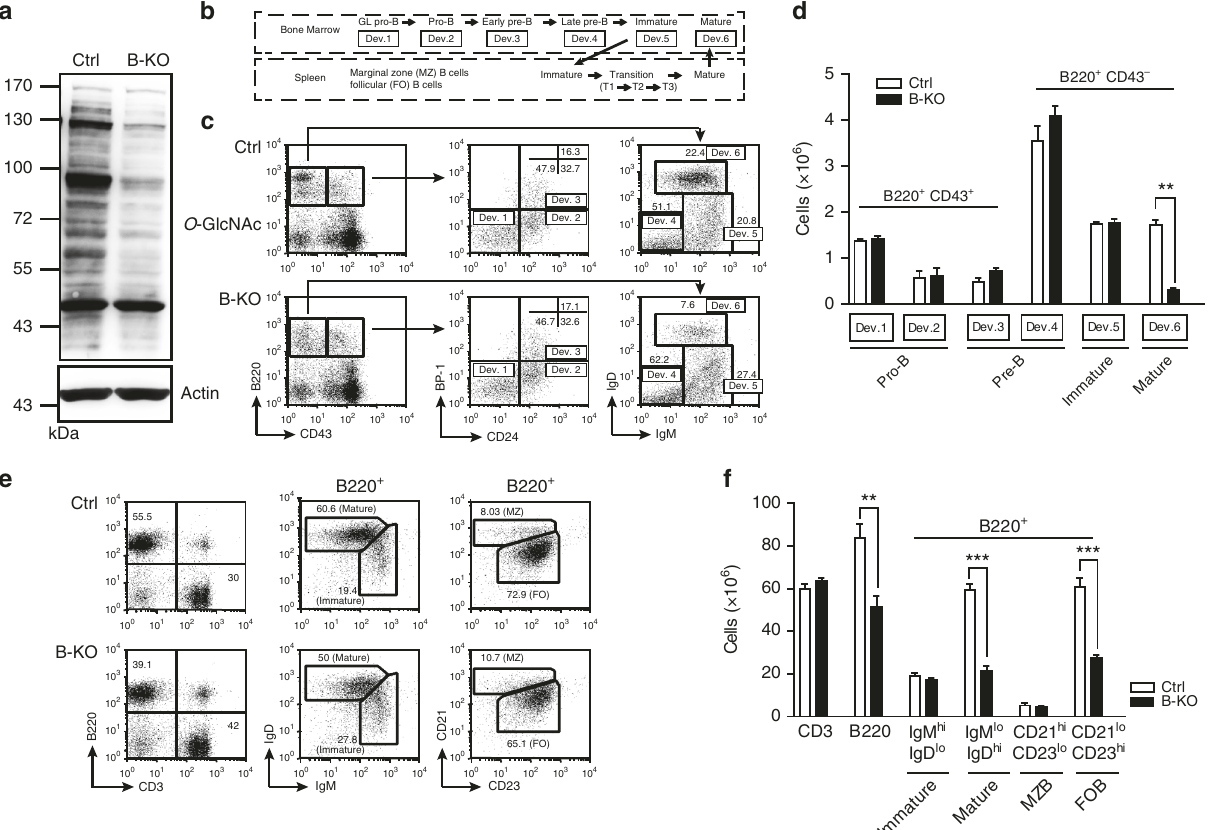
Fig. 1 Deletion of Ogt during B-cell development results in reduced mature B cells. a The levels of O -GlcNAcylation in Ctrl and B-KO splenic B cells were veri fi ed by immunoblotting using anti- O -GlcNAc antibody. Actin was used as the protein loading control. b Flow chart showing the developmental stages of B cells in bone marrow and spleen as used to examine the frequency of B cells in Ctrl and B-KO mice. GL: germline. c Bone marrow single-cell suspensions from Ctrl and B-KO mice were subjected to fl ow cytometric analysis to quantify the frequency of the cells in various B-cell developmental stages. d Bar graphs showing the number of various B-cell subsets in Ctrl and B-KO mice during development in bone marrow. e Flow cytometric analysis showing the frequency of B-cell subsets in the spleen of Ctrl and B-KO mice. f Bar graphs showing the number of B-cell subsets in Ctrl and B-KO spleens. The numbers shown in dot plots in c and e are the percentages in quadrants or gates. The results in d and f are the mean ± s.e.m. ( n = 3). **P < 0.01, ***P < 0.001 (two- tailed unpaired t